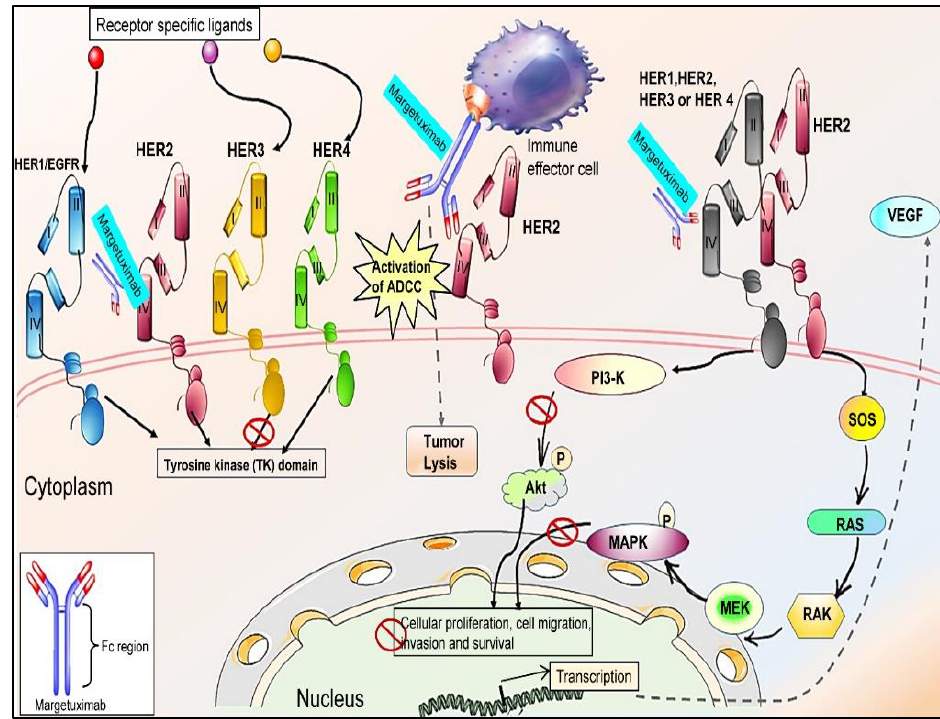
Figure 3. Schematic representation of the mechanism underlying the action of margetuximab. Margetuximab is an Fc-optimized mAb that binds to ECD IV of the HER2 receptor, thus preventing the formation of HER2 – HER2 homodimers and ligand-independent HER2 – HER3, HER2 – HER1, and HER2 – HER4 complexes/heterodimers. It enhances ADCC, leads to tumor lysis, and inhibits the TK signaling cascade, thus limiting cancer cell proliferation, migration, invasion, and survival. Figures were generated using Microsoft PowerPoint and free templates obtained from https://smart.servier.com/ (accessed on 9 June